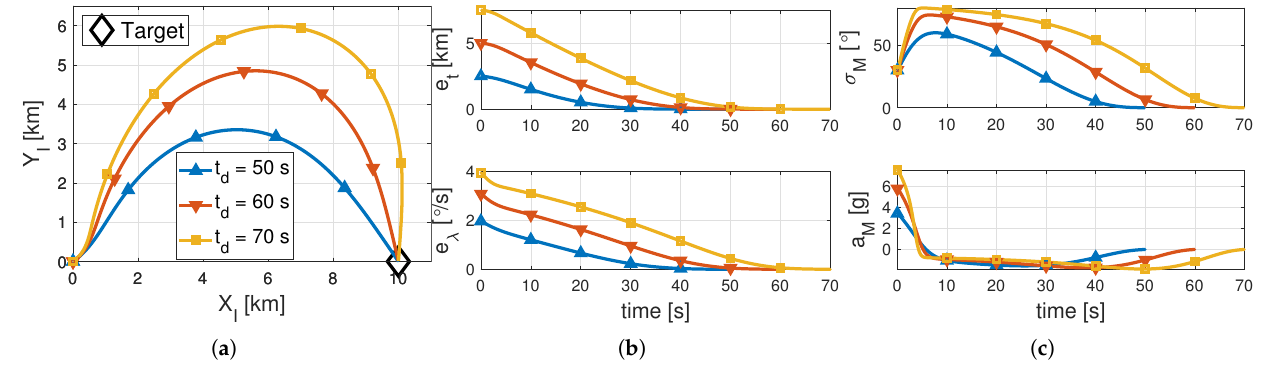
Figure 3. Simulation results under the proposed law for the desired constraint of t d = 50s, 60s, and 70s. ( a ) Flight trajectories; ( b ) error variables; ( c ) state and input